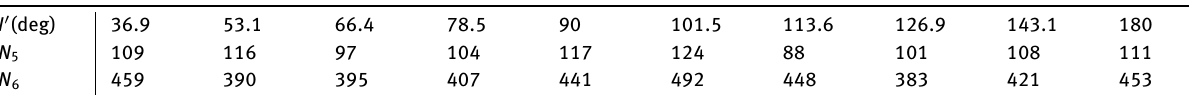
Table 2. Results of analysis of the nodes and MOID-values for the 300 hyperbolic comets relatively to the orbits of the 100 meteoroid